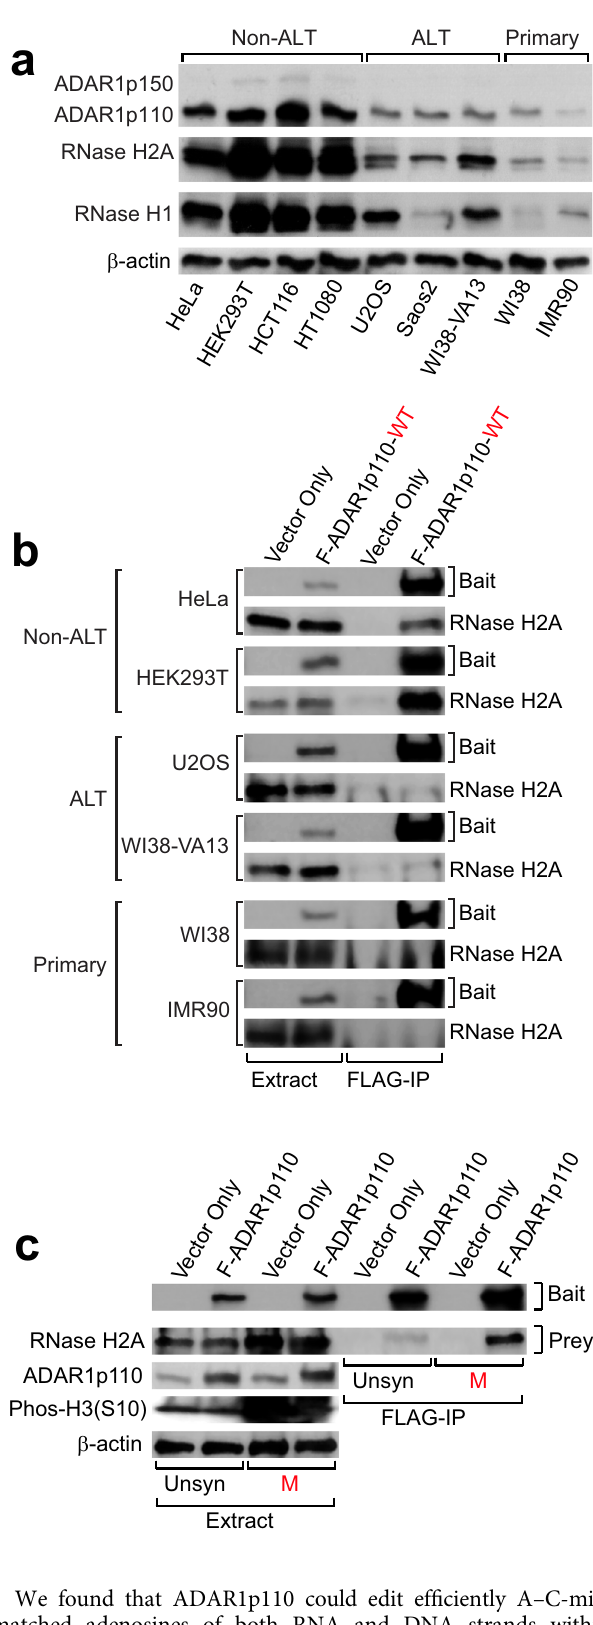
We found that ADAR1p110 could edit ef fi ciently A – C-mis- matched adenosines of both RNA and DNA strands within telomeric RNA:DNA hybrids and convert them to I:C-matched Watson – Crick base pairs. Interestingly, telomeric variant repeats have been reported to expand during ALT-mediated inter- and/or intra-telomeric recombination in ALT cells, and by a currently